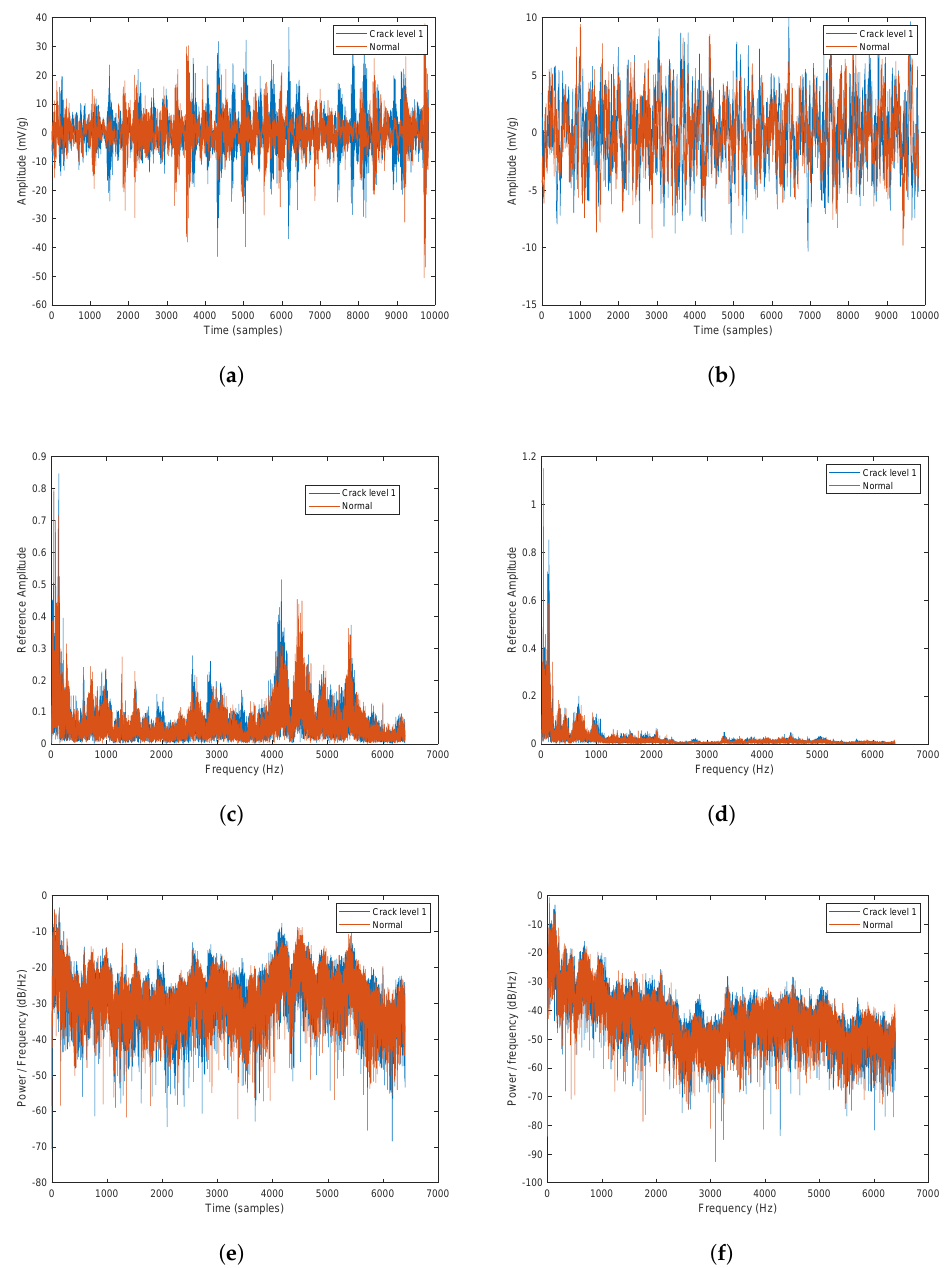
Figure 4. Sample vibration signal. Left and right longitudinal accelerometers with load of 4 tons, speed of 20 km/h, and crack level 1. ( a ) Time Signal left Accelerometer; ( b ) Time Signal right Accelerometer; ( c ) Frequency Spectrum left Accelerometer; ( d ) Frequency Spectrum right Accelerometer; ( e ) Power Density Spectrum left Accelerometer; ( f ) Power Density Spectrum right